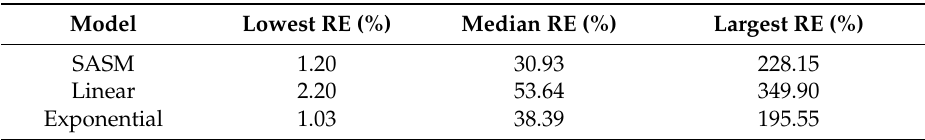
Table 3. Absolute relative error for the SASM, linear and exponential models derived from the bootstrap distribution of the TSS